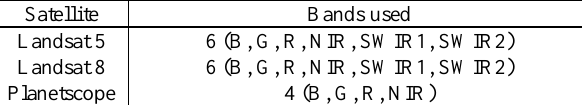
Table 2. Bands available for satellite imagery